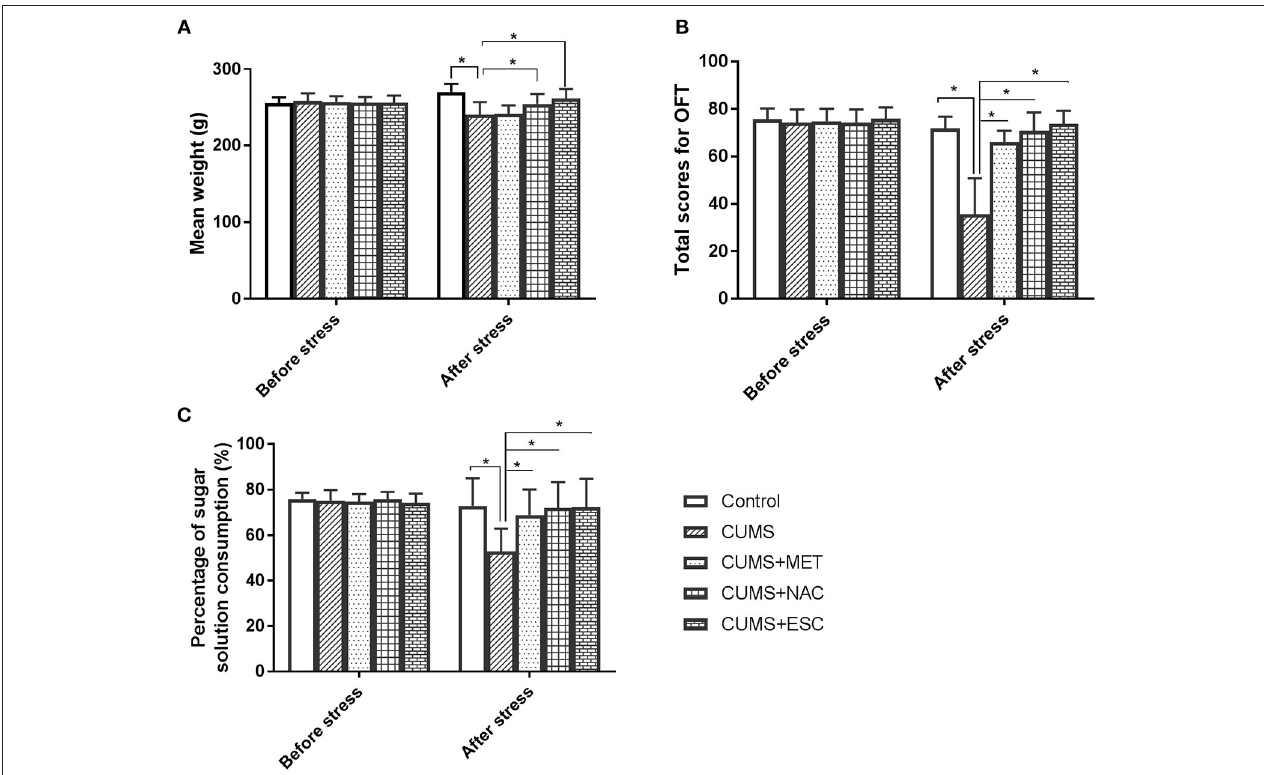
FIGURE 2 | Effect of MET, NAC, and ESC on the CUMS-induced depression-like behaviors. (A) Effect of MET, NAC, and ESC on the weight of CUMS-induced rats. (B) Effect of MET, NAC, and ESC on the scores of open field test (OFT). (C) Effect of MET, NAC, and ESC on the scores of sucrose preference test (SPT). * P < 0.05 (one way ANOVA), n =